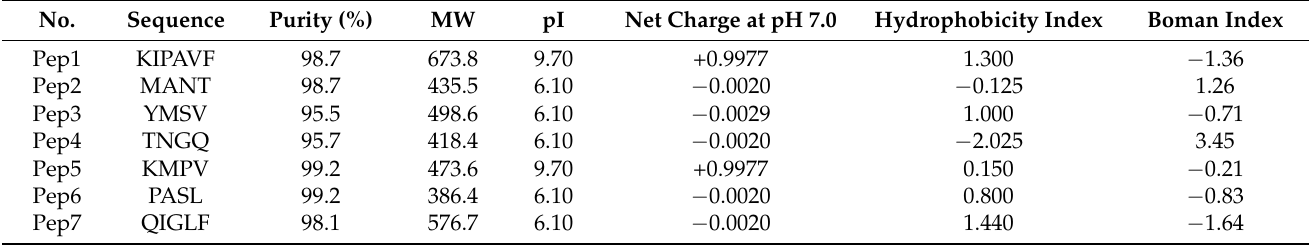
Table 1. Peptide information and calculated physicochemical